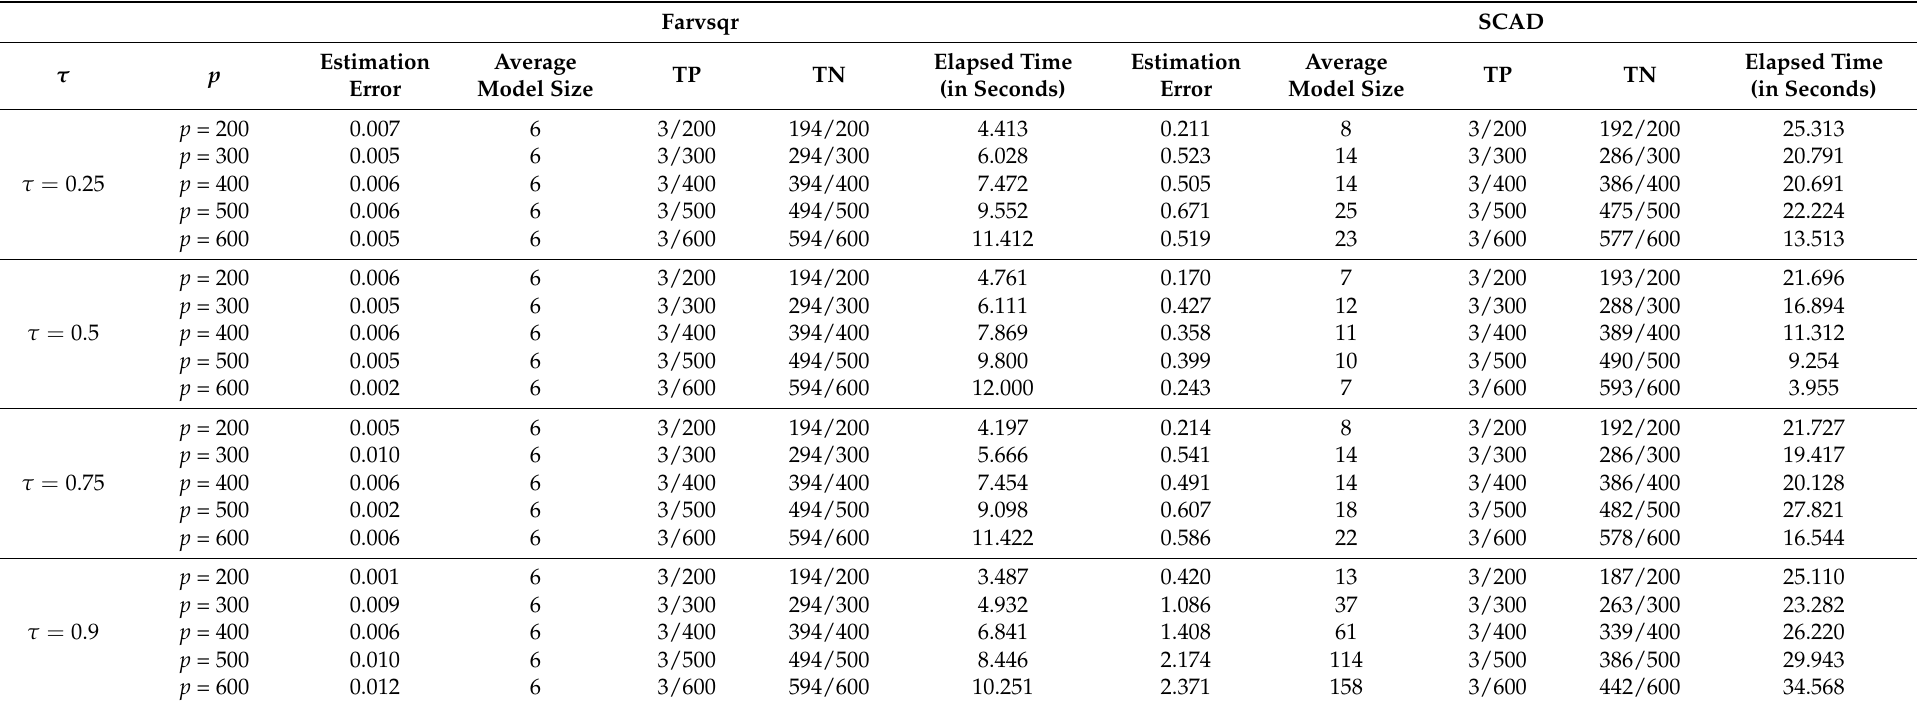
Table 14. The comparison for n = 1000, N ( 0,1 ) with the factor model between Farvsqr and SCAD. Farvsqr